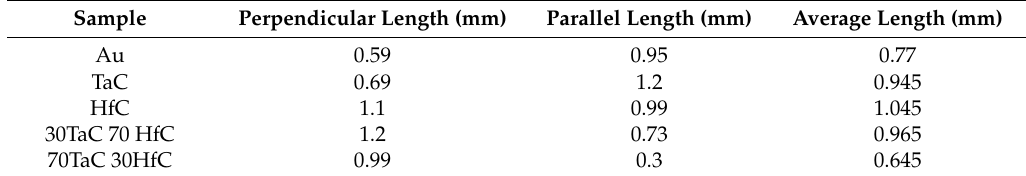
Table 2. Measurement of length.